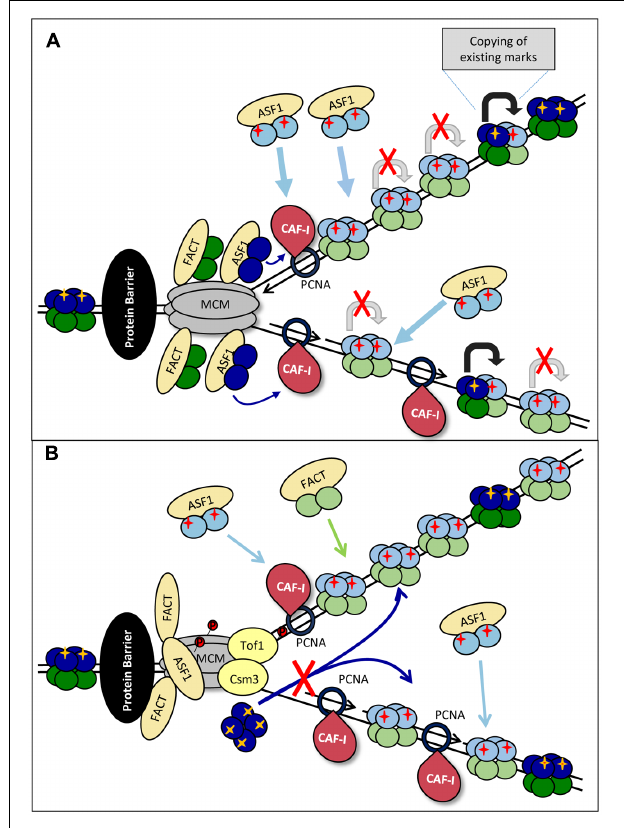
FIGURE 3 | Models for loss of histone marks. (A) Splitting of the H3/H4 tetramer. Upon approaching the impediment (a non-histone DNA-binding protein is shown by a black oval) the forks are slowing down. “Old” H3/H4 tetramers (dark blue) are split into dimers by ASF1 and transported behind the fork and delivered to CAF-I to form mixed tetramers with the new H3/H4 histones (light blue). The PTMs on the “old” dimers (yellow cross) serve as templates for the transmission of the marks to the “new” dimers (shown by gray arrows) from which pre-deposition marks are erased. The slowing and eventual pausing of fork reduces the availability of “old” histones, resulting in a disproportionately high assembly of “new” histones and loss of histone PTMs. (B) Inhibition of tetramer transmission. The impediment (a non-histone DNA-binding protein is shown by a black oval) and fork pausing is accompanied by the phosphorylation of MCM by DDK. This phosphorylation inhibits MCM helicase activity, but also its putative H3/H4 chaperone activity. Consequently, the delivery of “old” tetramers is precluded and CAF-I assembles nucleosomes from newly synthesized H3/H4